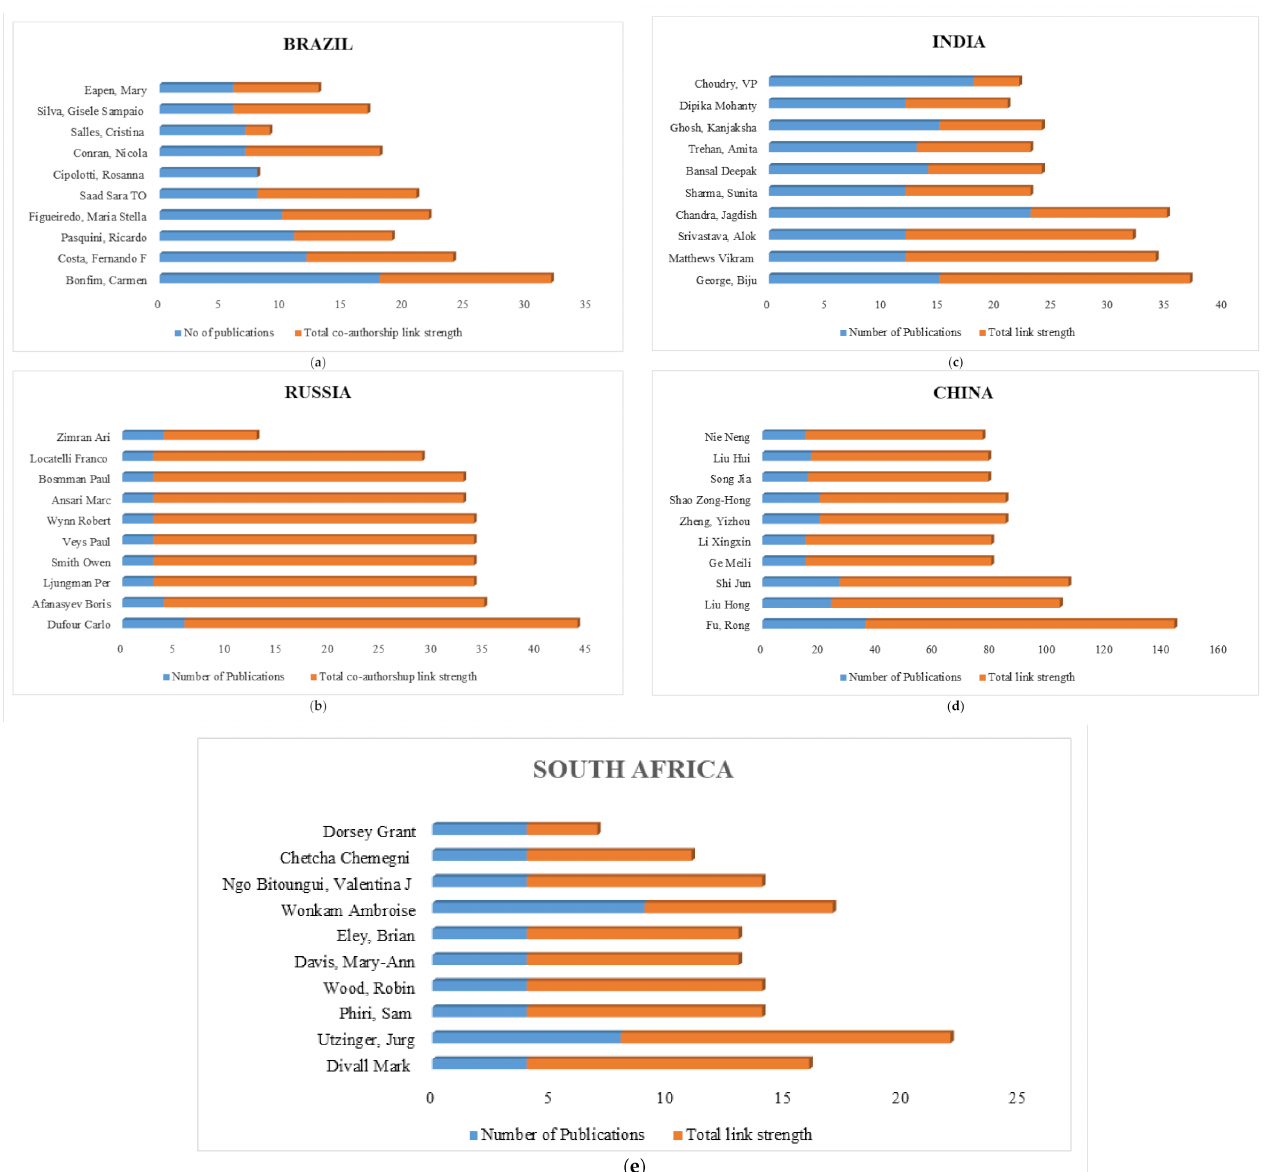
Figure 3. ( a ): Top ten authors from Brazil with at least 5 publications within the 3 decades covered in this study. ( b ) Top ten authors from Russia with at least 3 publications within the 3 decades covered in this study. ( c ) Top ten authors from India with at least 12 publications within the 3 decades covered in this study. ( d ) Top ten authors from China with at least 15 publications within the 3 decades covered in this study. ( e ) Top ten authors in South Africa with at least 4 publications within the 3 decades covered in this